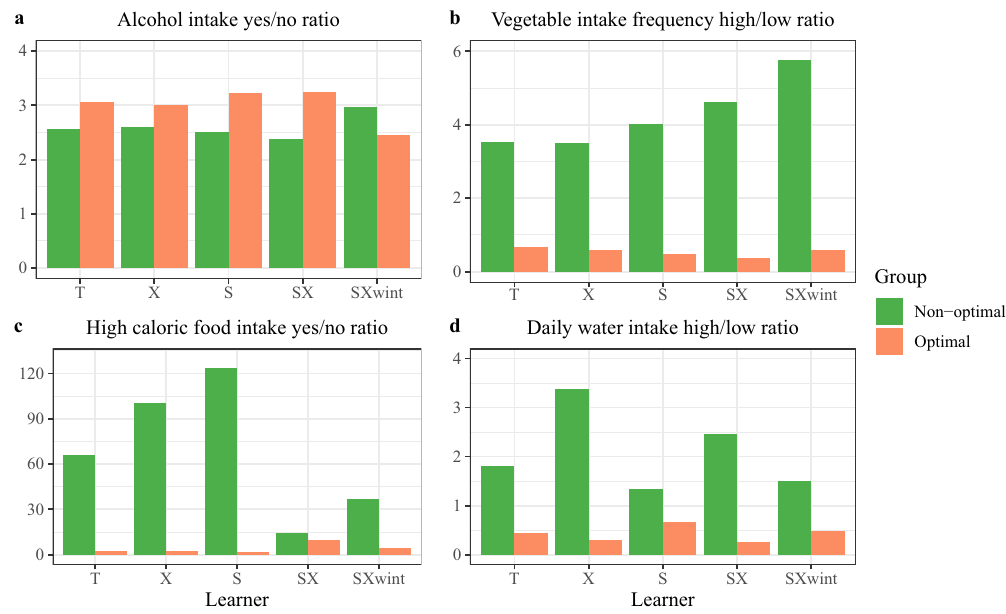
Figure 4. Comparison of sample size ratios between personalized optimal and non-optimal groups for T, X, S, SX and SXwint learners; ( a ) Alcohol CALC Yes/No Ratio = (Sample size with CALC = Yes)/(Sample size with CALC = No), ( b ) Vegetable FCVC High/Low Ratio = (Sample size with FCVC >2)/(Sample size with FCVC